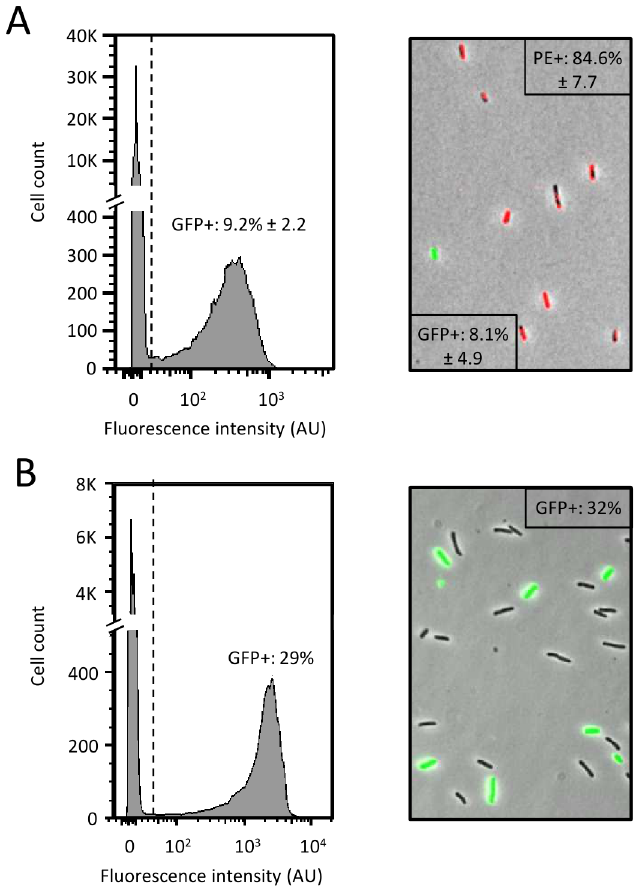
Fig 5. Specific detection of E . coli TD2158 with the phagosensor HK620::PrrnB-gfp. Co-cultures of E . coli TD2158 and S . enterica (ratio = 1:10) (A) or E . coli TD2158 and E . coli MG1655 (ratio 3:10) (B), were infected with the HK620::P rrnB - gfp phage and incubated at 30°C for 1 hour. The fluorescence intensity of individual cells gated to the bacterial population was determined by flow cytometry (left panels). The dotted line represents the limit between negative (no fluorescence) and positive (fluorescence) cells as determined using the fluorescence negative control composed of a non infected co-culture. Mean fluorescence was calculated from at least triplicate samples. Co-culture samples were analyzed by epifluorescence microscopy imaging of co-culture sample (Right panels). Red fluorescence population was S . enterica labeled with antibody coupled with phycoerythrin (PE), GFP-induced green fluorescent population was the infected bacteria and non fluorescent bacteria were E. coli MG1655. Average fluorescence values were obtained from triplicate